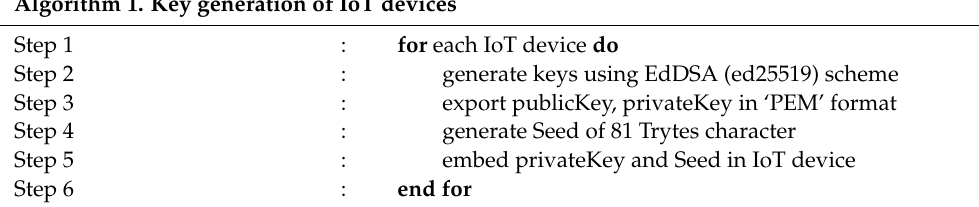
Algorithm 1. Key generation of IoT